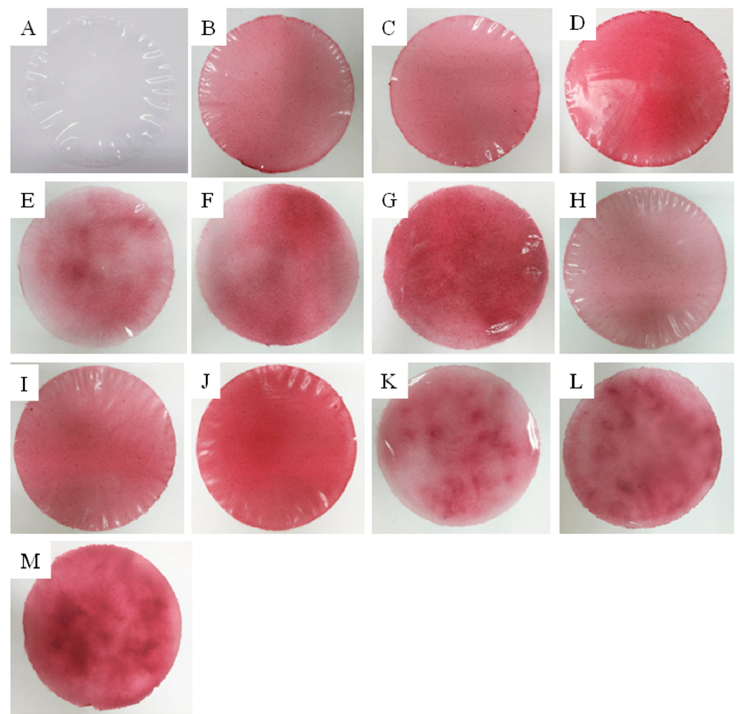
Figure 2. Photographic images of the films samples with 0%, 20%, 30% and 40% of